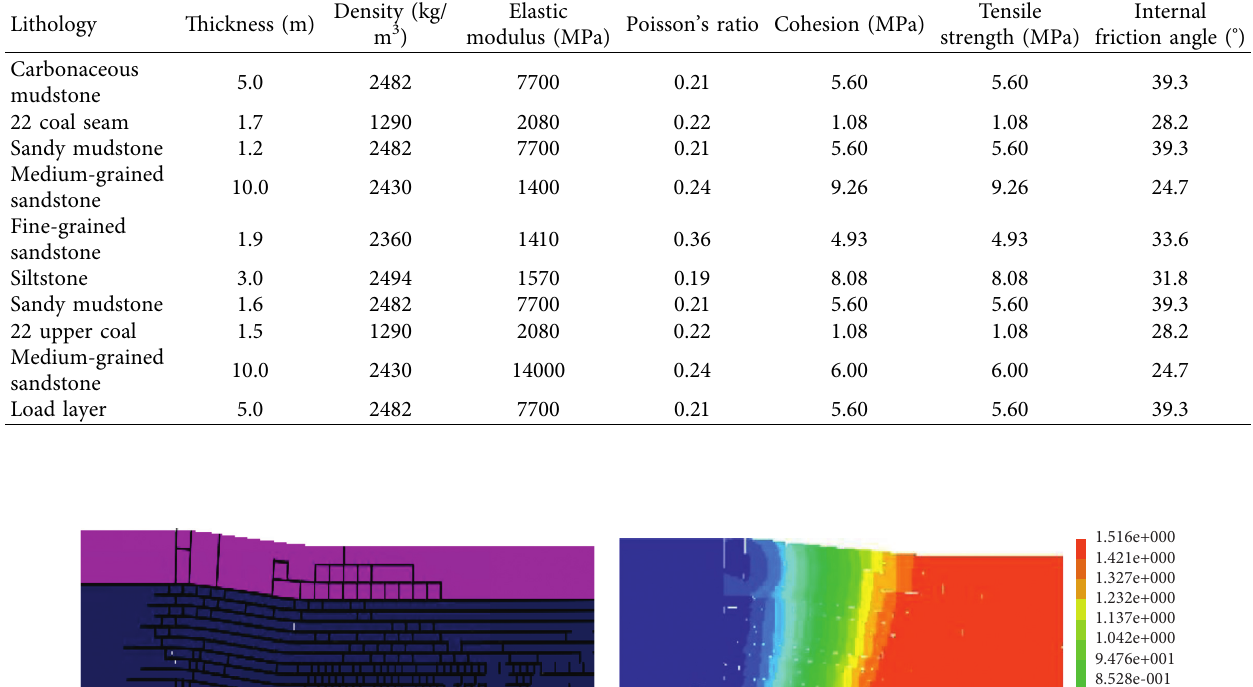
Table 1: Mechanical parameters of the coal and rock strata considered in the numerical model. Lithology